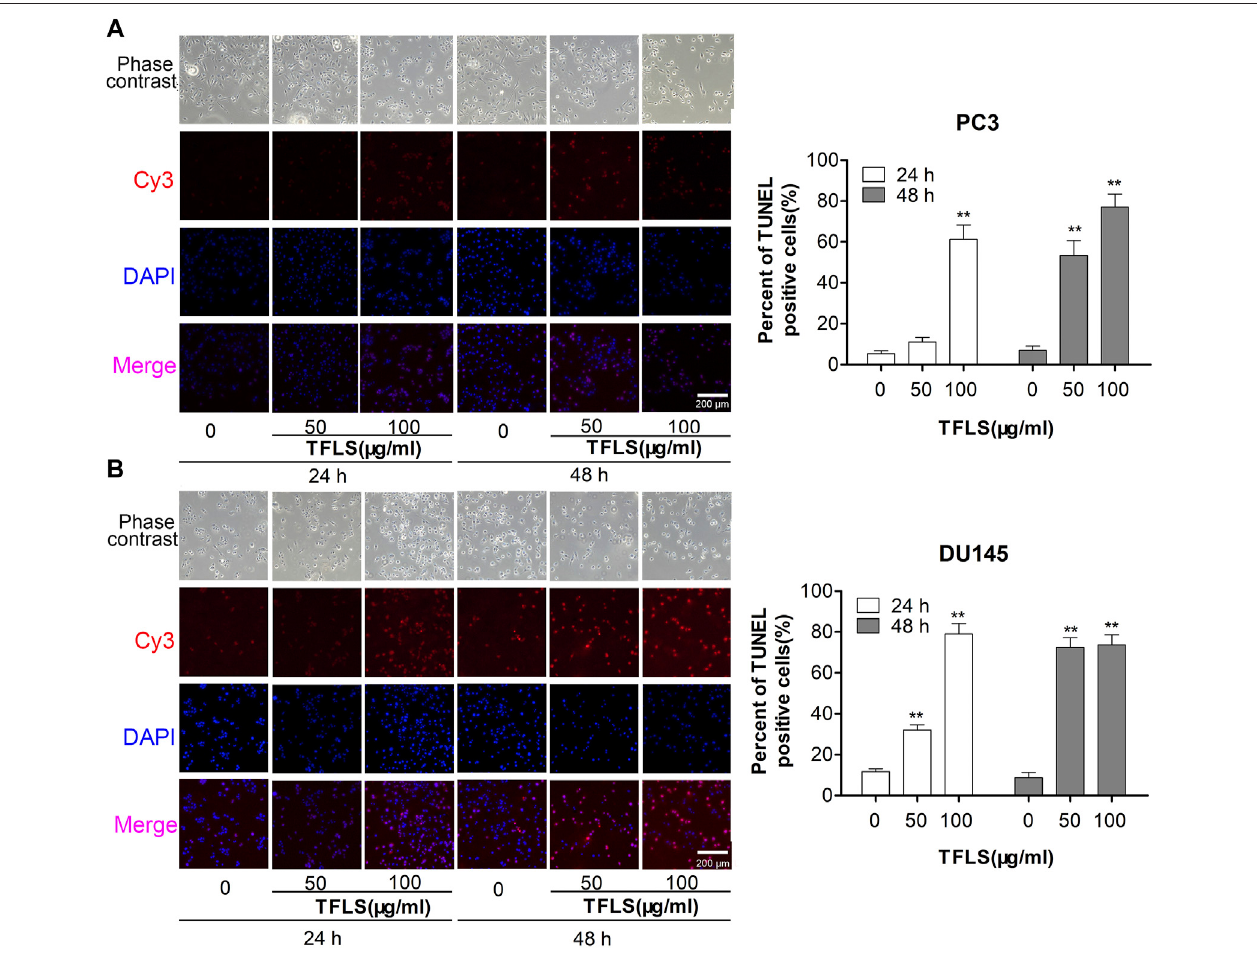
FIGURE4| PC3andDU145cellsweretreatedwithTFLS,andtheapoptoticcellsweredetectedbyTUNELassay.RepresentativeimagesofapoptosisofPC3and DU145 cells with 0, 50, 100 μ g/ml of TFLS treatment for 24 or 48 h. TUNEL positive cells (red) were shown. Cell nuclei were detected by DAPI (blue). The images were obtained by a fl uorescence microscope. Bar plots of the percentages of TUNEL positive cells [ (A) PC3 cells; (B) DU145 cells]. Data are expressed as mean ± SEM. Compared with control group: * p < 0.05; ** p < 0.01.